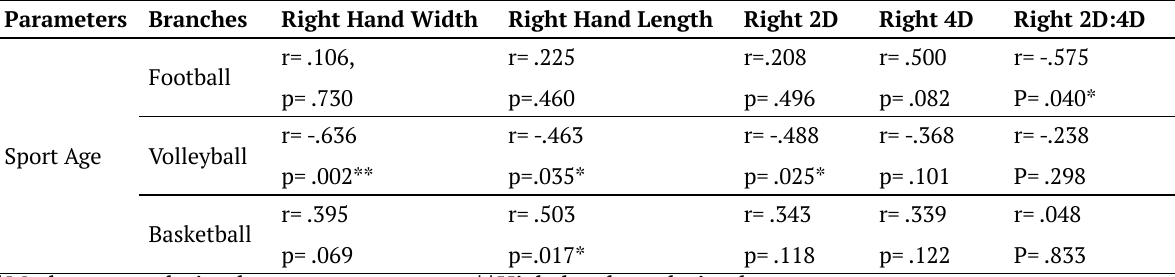
Table 4. The Relationship Between Sports Age and Right Hand Parameters Parameters Branches